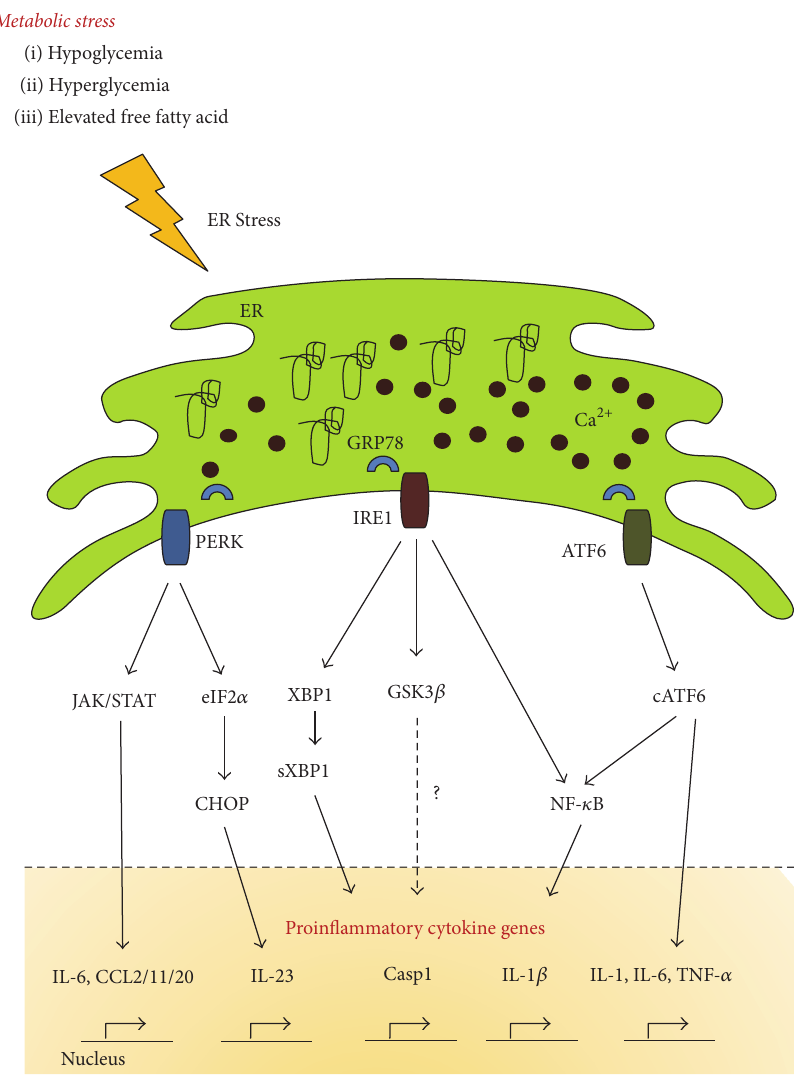
Figure 1: Metabolic stress-mediated induction of an inflammatory response via ER stress signaling pathways. Metabolic stressors such as hypoglycemia, hyperglycemia, and elevated free fatty acids induce endoplasmic reticulum (ER) stress pathways that increase production of inflammatory cytokines. PERK activation increases IL-6, IL-23, CCL2, CCL11, and CCL20 gene expression via the JAK/STAT and eIF2 𝛼 - CHOP signaling pathways. IRE1 activation results in increased secretion of a diverse group of proinflammatory cytokines through XBP1, GSK3 𝛽 , and the NF- 𝜅 B signaling cascade. Lastly, ER stress promotes ATF6 cleavage in the Golgi complex, which triggers proinflammatory cytokine production via the NF- 𝜅 B pathway. GRP78: glucose-regulated protein 78; PERK: pancreatic ER kinase; IRE1: